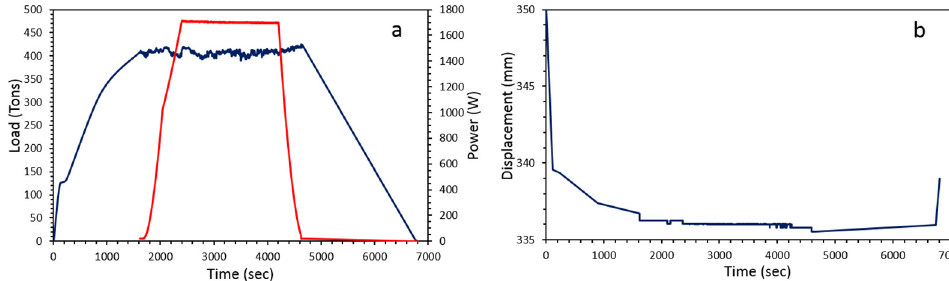
Figure 7. ( a ) Load (tons, in blue) and power (W, in red) parameters as programmed and recorded during experiments and associated displacement in mm ( b ). During dwell, both load and power, i.e., pressure and temperature, are very stable. Most of the displacement occurs during cold compression (few mm) whereas it is only of few tens to hundreds of microns during heating and dwell.